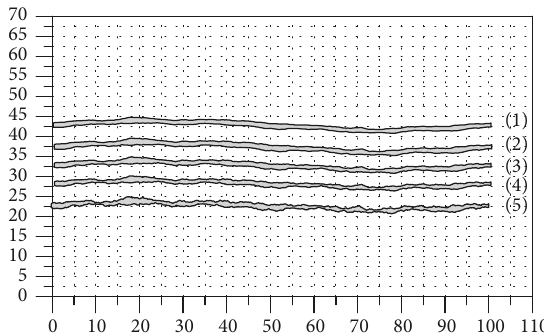
Figure 1: Single rough-walled fractures with fractal dimension ranging from 2.0 to 2.4 (unit: